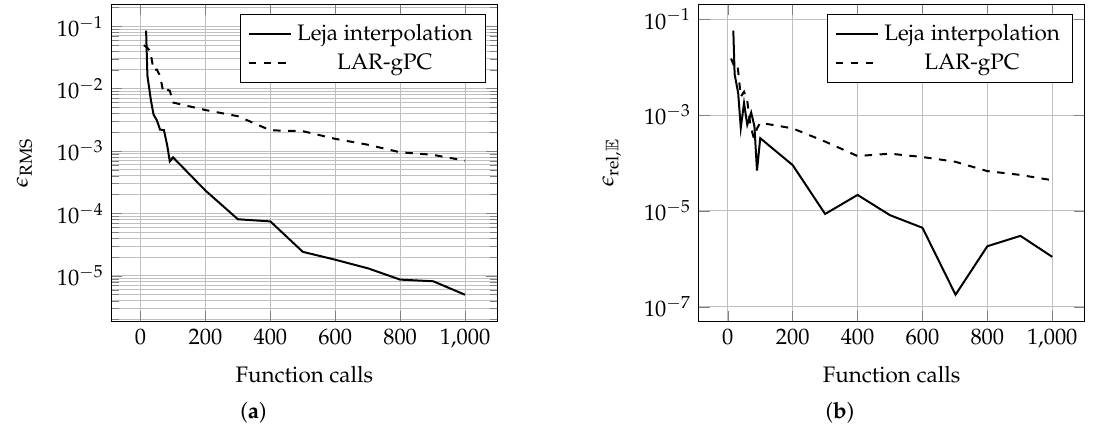
Figure 4. Cost-error relation for the approximations of the meromorphic function. The approximations are constructed with a dimension-adaptive weighted Leja interpolation algorithm [37] and with a degree-adaptive LAR-gPC algorithm [9,50]. The size of the validation sample is Q = 10 5 . The reference expected value is computed with quasi-MC integration based on a Sobol sample size equal to 10 8 : ( a ) RMS validation error, ( b ) Expected value relative